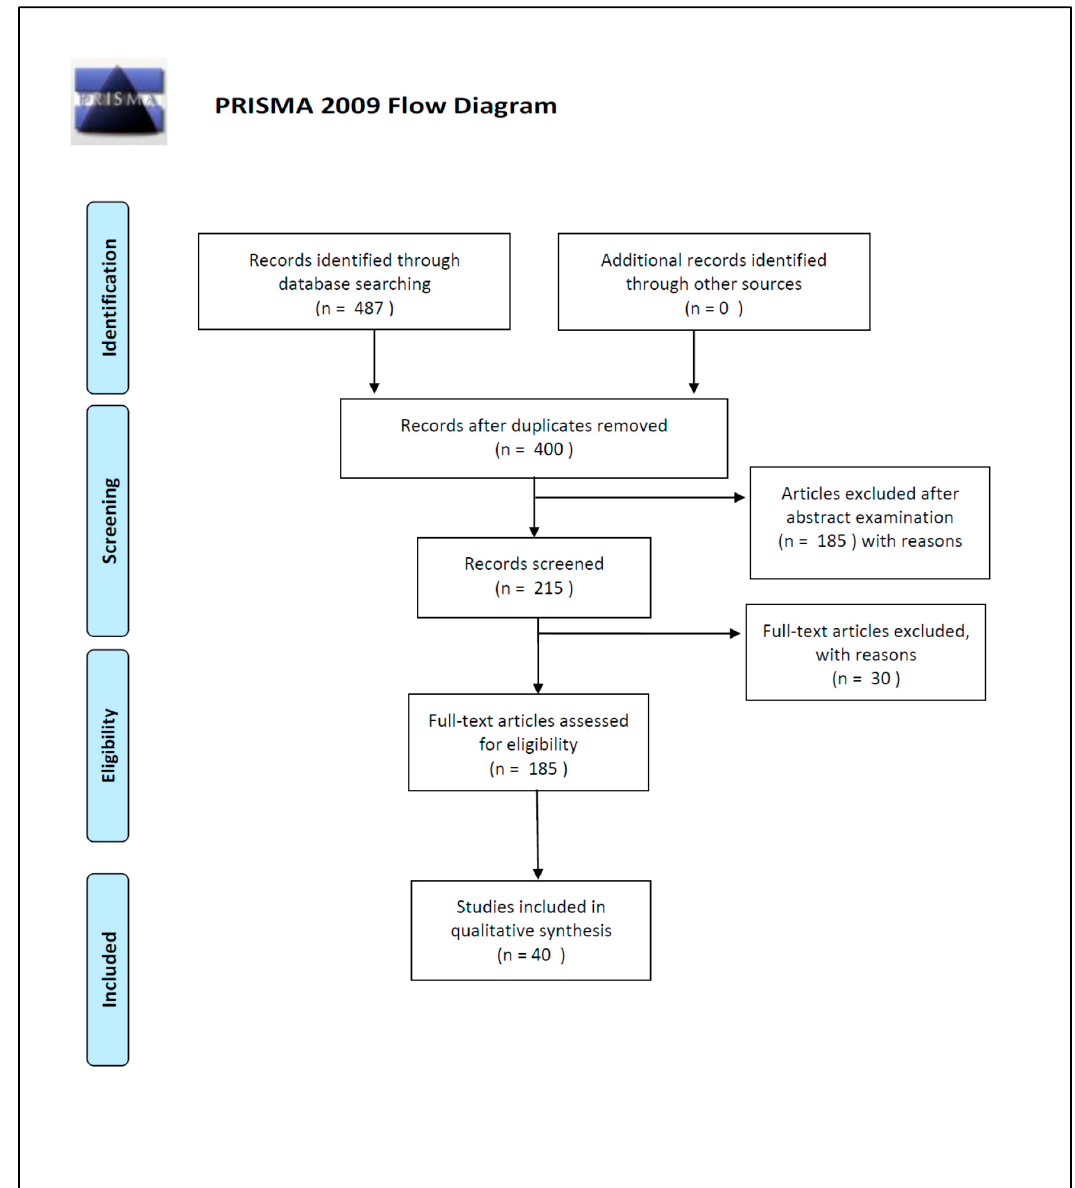
Figure 2. PRISMA 2009 Flow Diagram.